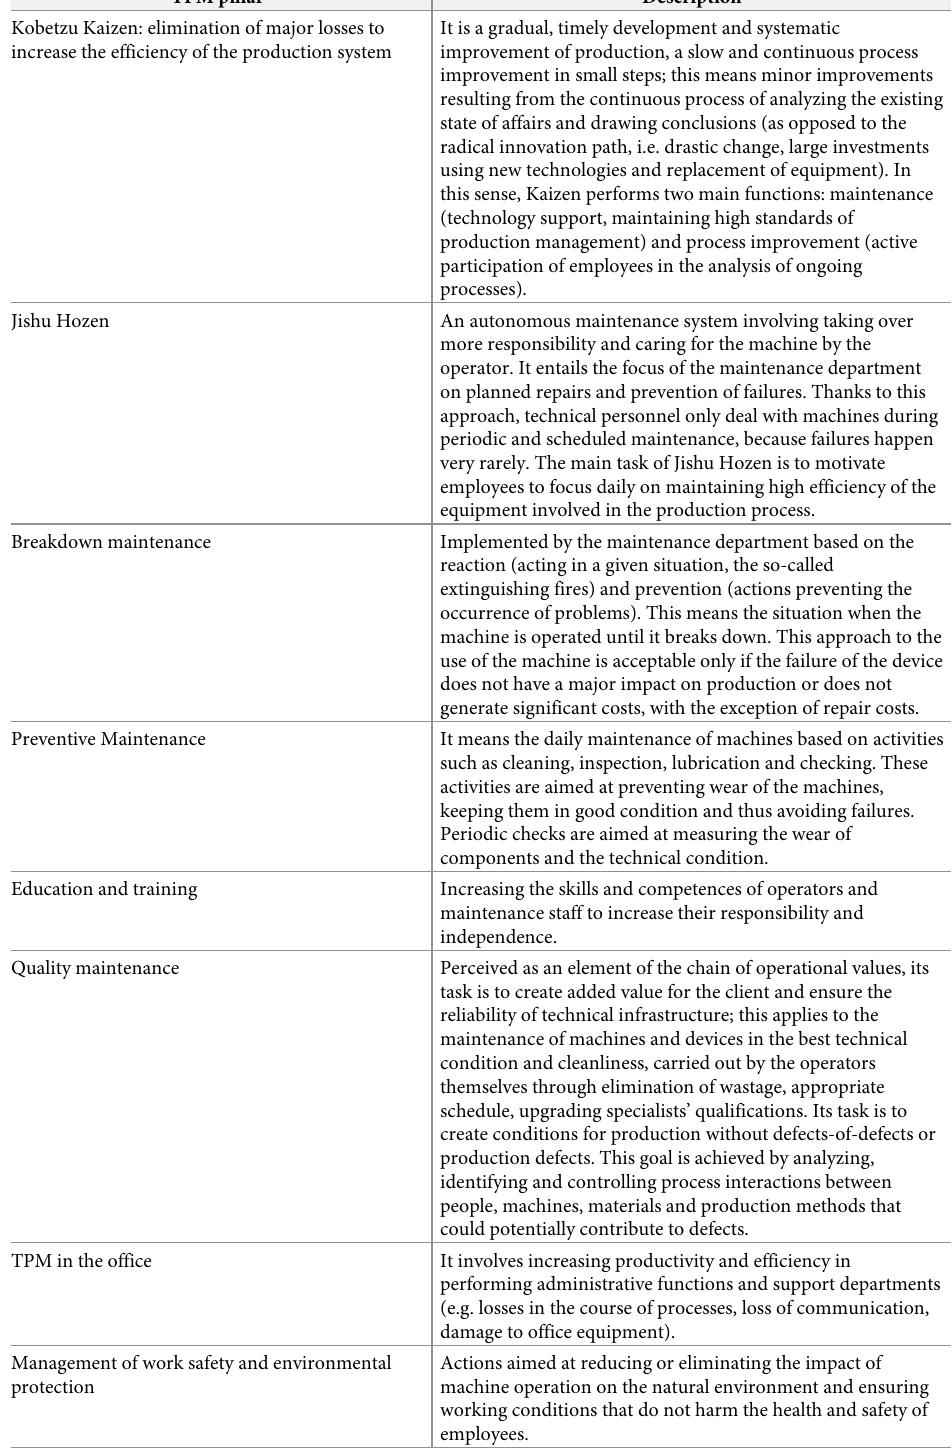
Table 1. TPM pillars